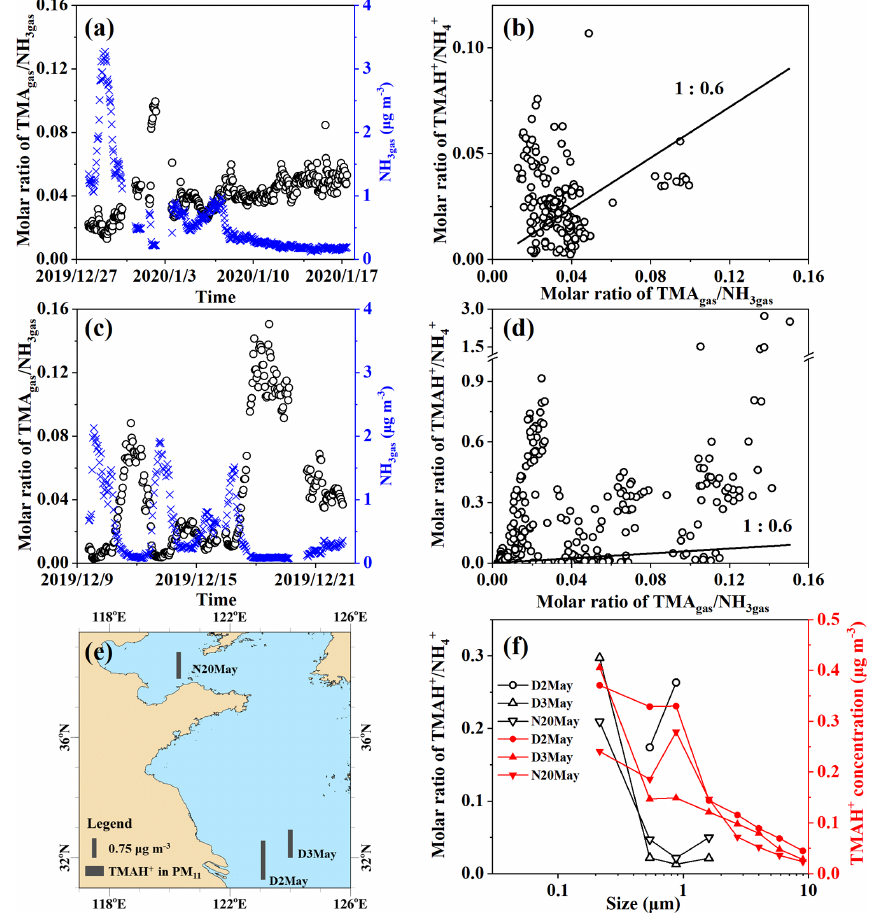
Figure 5. Time series of molar ratios of TMA gas / NH 3gas (a) and (c) in Campaigns B and A; correlation between TMA gas / NH 3gas and (b) and (d) in Campaigns B and A; map of particulate TMAH + (e) and size distributions of TMAH + / NH + TMAH + / NH + 4 concentrations of TMAH + (f) in Campaign